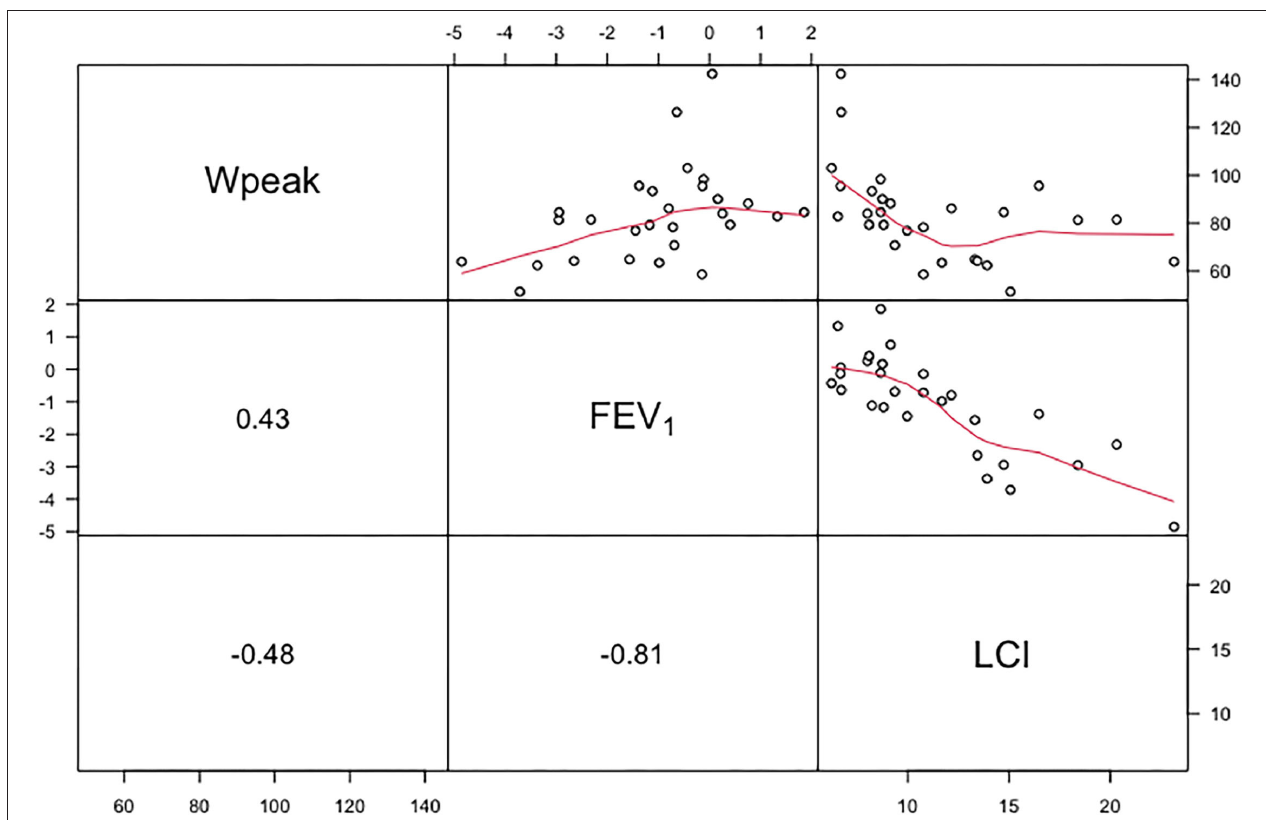
FIGURE 1 | Upper panel shows the relationship between ppWpeak (Wpeak), z -score of FEV 1 and LCI. The curved lines represent nonparametric regressions. The lower panel shows correlation coefficients (rho). FEV 1 , forced expiratory volume in 1s; LCI, lung clearance index at 1/40th of starting concentration.